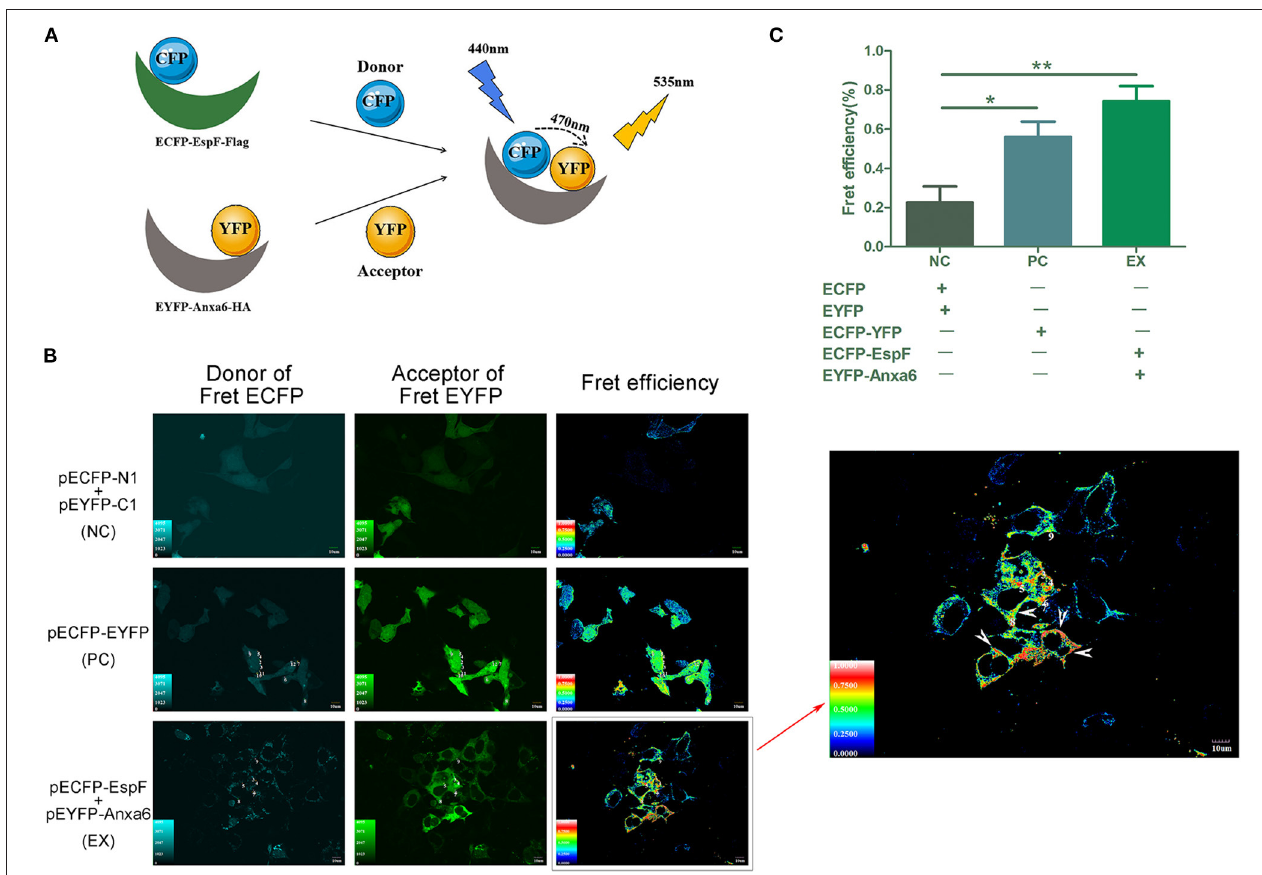
FIGURE 2 | Analyses of the interaction between EspF and ANXA6 protein by FRET. Principle of the FRET assay was shown (A) . espF was fused to the N-terminal of pECFP-N1, anxa6 was fused to the C-terminal of pEYFP-C1. CFP acts as the donor, YFP acts as the acceptor. A FRET phenomenon occurs when the distance between the two proteins is lower than 10nm, indicating an interaction between these two proteins. EspF-ANXA6 protein complex produces FRET phenomenon in HEK293 cells (A) . Cells with FRET phenomenon are indicated by the arrow (B) . Cells co-transfected with pECFP-N1 and pEYFP-C1 were set as negative control (NC). Cells transfected with pECFP-EYFP, in which distance between ECFP and EYFP is below 10nm and produce a FRET phenomenon, were positive control (PC). Cells co-transfected with pECFP-EspF and pEYFP-Anxa6 were set as the experimental group (EX). Quantitative analysis of FRET efficiency between each group is shown (C) . Error bars represent the means ± SD of triplicates. T -test results are between the EX/PC and NC, *Statistically significant difference. * p < 0.05. ** p < 0.01.